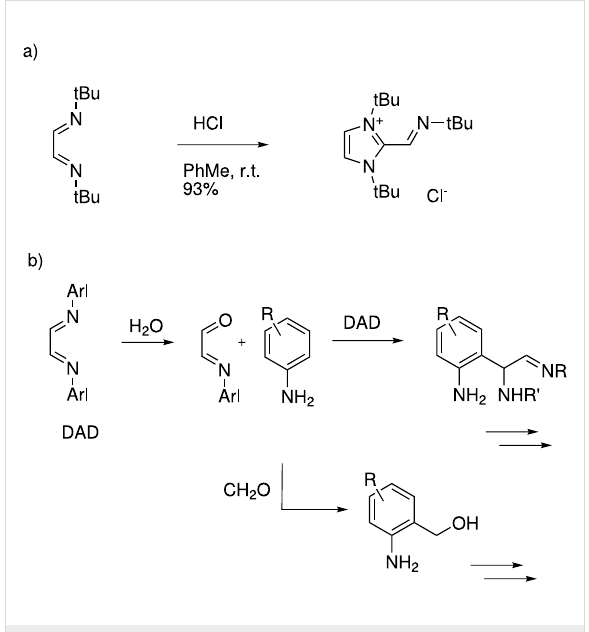
Scheme 3: Potential side-reactions in the imidazolium salt